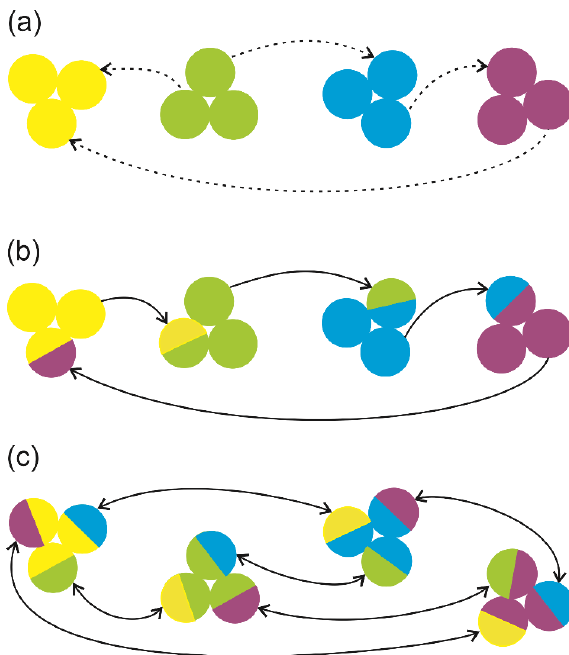
Figure 1. Schematic image depicting (a) multicultural, (b) cross- cultural and (c) intercultural (adapted from Schriefer,